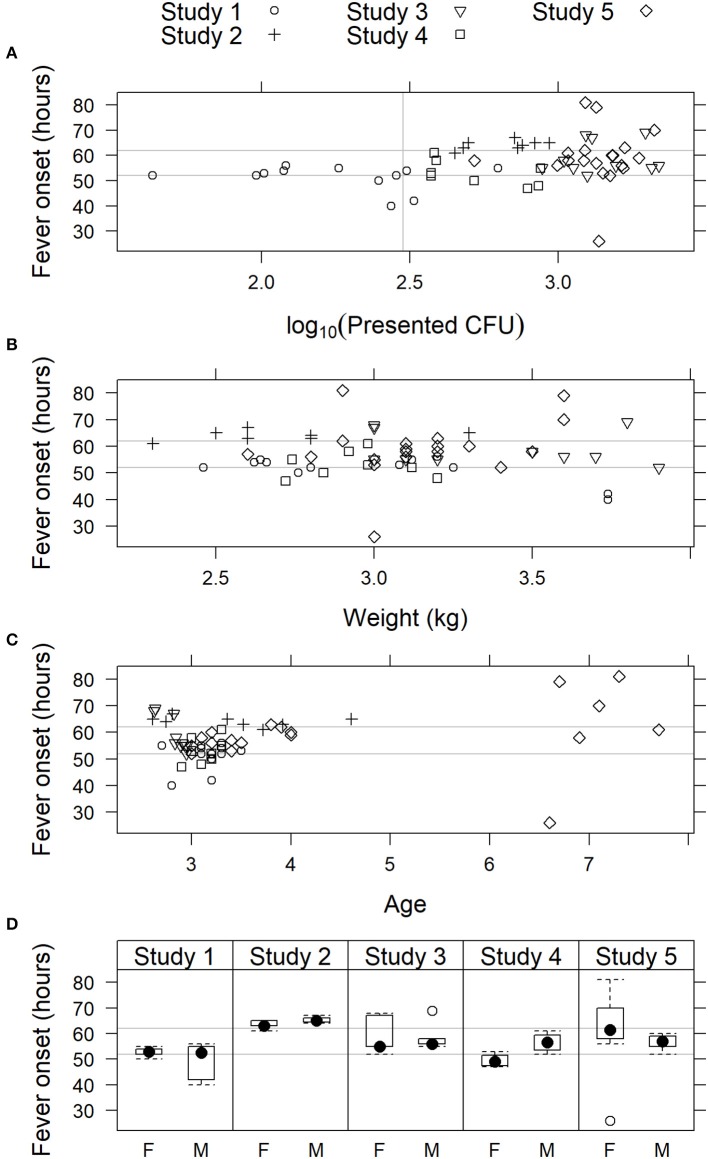
Relationship of fever onset with physiological parameters in cynomolgus macaques exposed to 43 to 2,182 cfu F. tularensis Schu S4. In studies where fever onset was modeled, time of onset is plotted vs. (A) presented dose of F. tularensis; (B) body weight; (C) age; and (D) sex: female (F) or male (M). In (A–C), individual animals are represented by symbols, while sex data is presented as box and whiskers plots. Light gray horizontal lines represent the 95% confidence limits (52 and 62 h) of fever onset across all five studies.